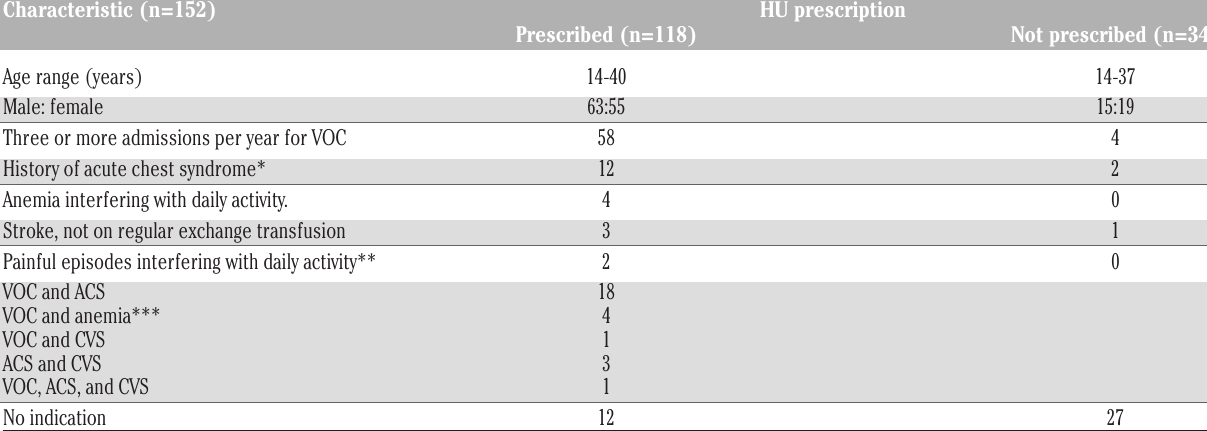
Table 1. Basic patients’ characteristics.